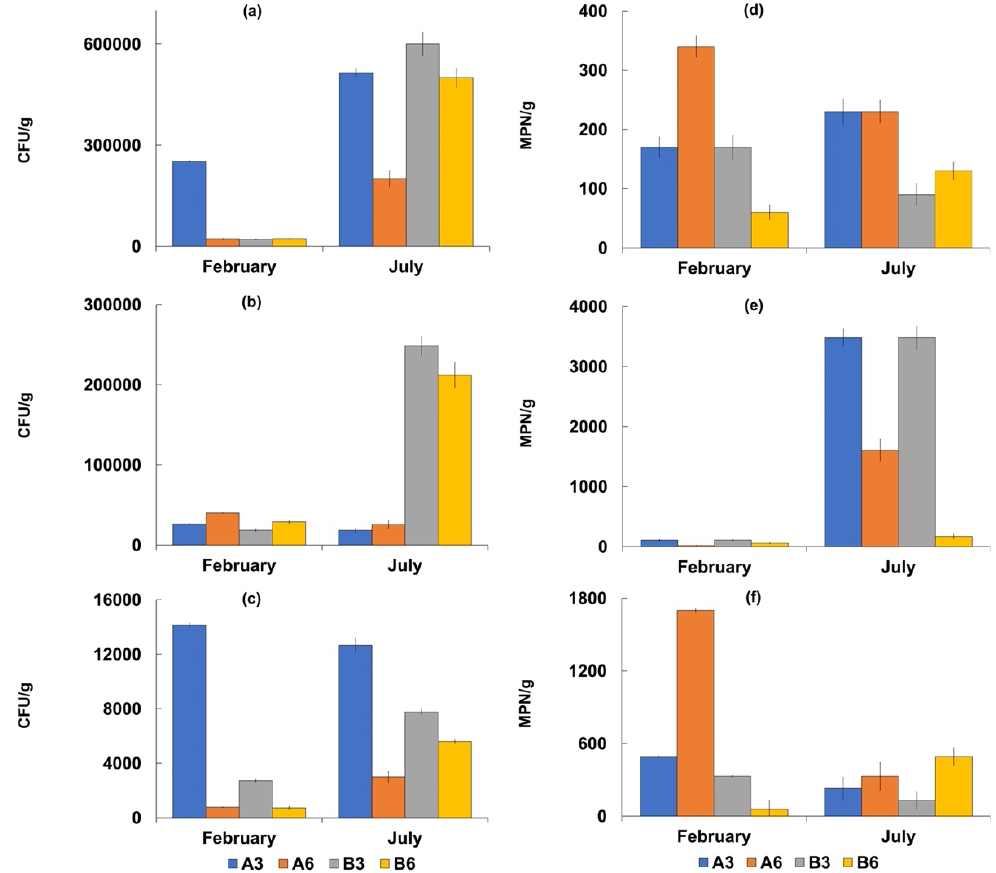
Figure 3. Concentrations of the considered microbiological parameters in sediment samples collected in February and July 2018 at the four sampling sites (A3, A6, B3, and B6). Bacterial counts are reported as mean values ± S.D. of three replicates. Bacterial counts are expressed as CFU/g for culturable heterotrophic bacteria at 22 ◦ C ( a ), culturable bacteria at 37 ◦ C ( b ) and culturable vibrios ( c ), and as MPN/g for fecal coliforms ( d ), fecal enterococci ( e ) and total coliforms ( f ). The concentrations of these microorganisms were always higher at Station A3 than at